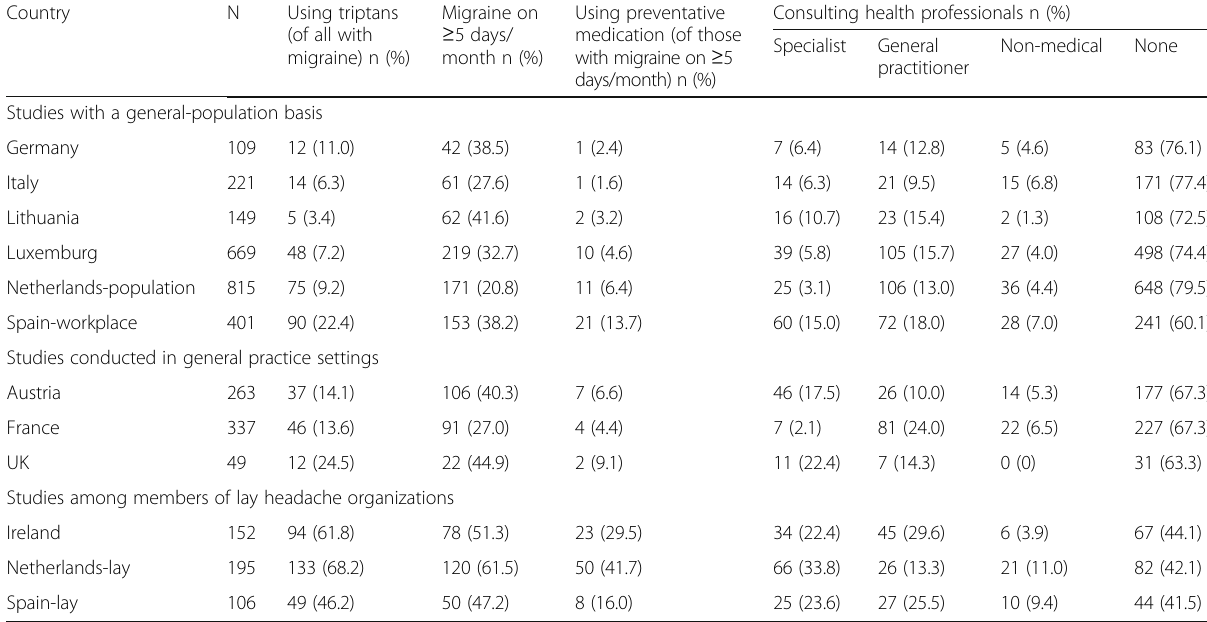
Table 3 Utilization of medical care by participants with migraine (N = 3466) Country N Using triptans (of all